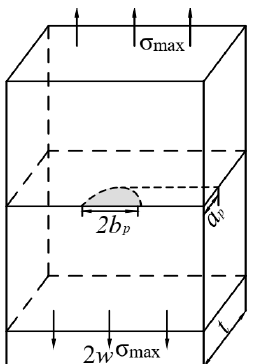
Figure 11. Schematic representation of the equivalent semi-elliptic crack.